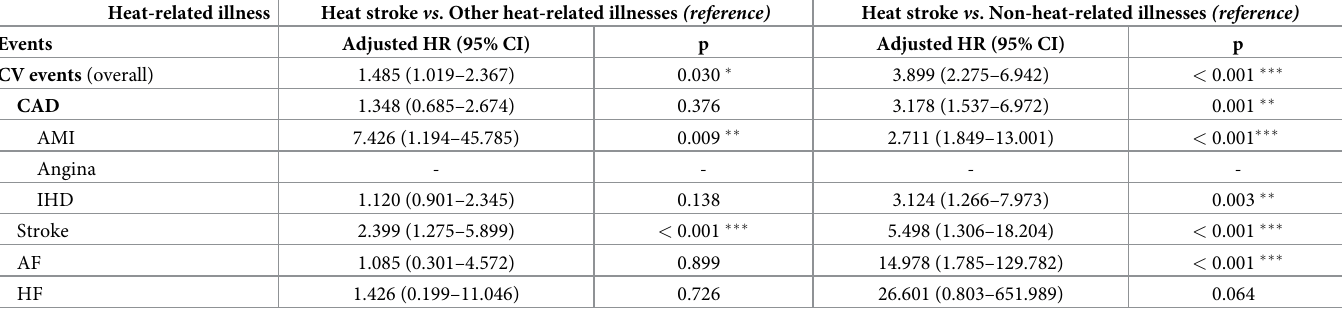
Table 3. Factors associated with cardiovascular diseases according to Cox regression in patients with heat stroke, other heat-related illnesses and Non-heat-ielated